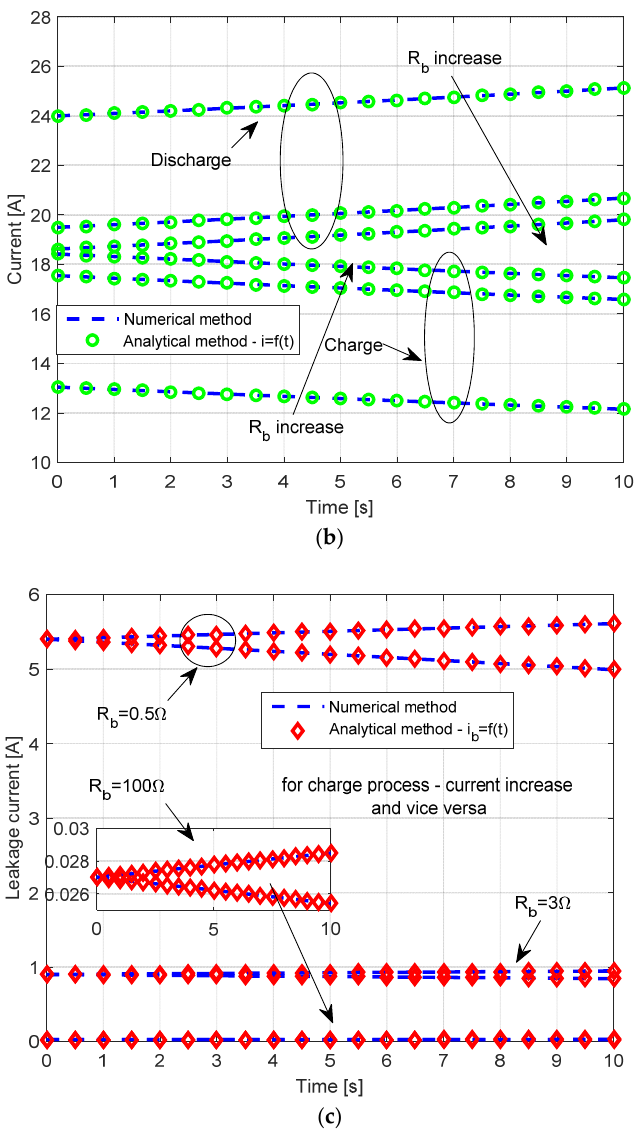
Figure 3. Charging and discharging characteristics of a SC at constant power using different parallel resistance values: ( a ) voltage versus time; ( b ) current versus time; ( c ) leakage current versus time.